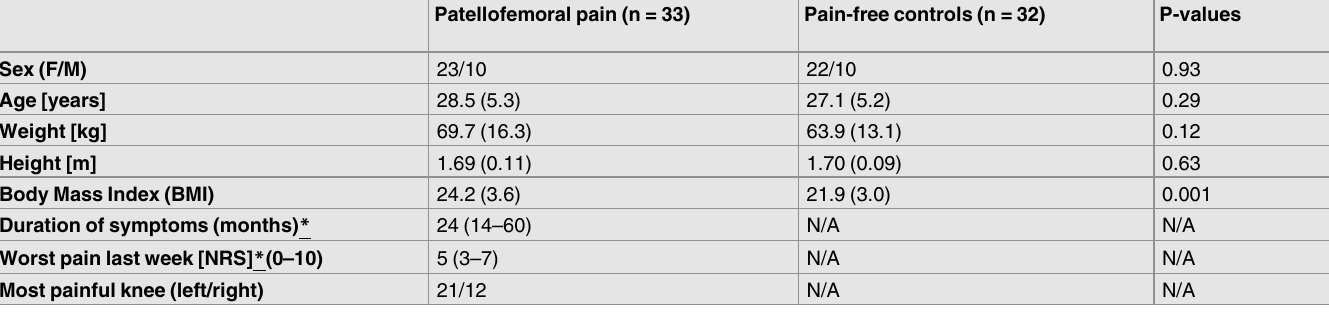
Table 1. Demographics and patient reported outcomes (presented as mean and standard